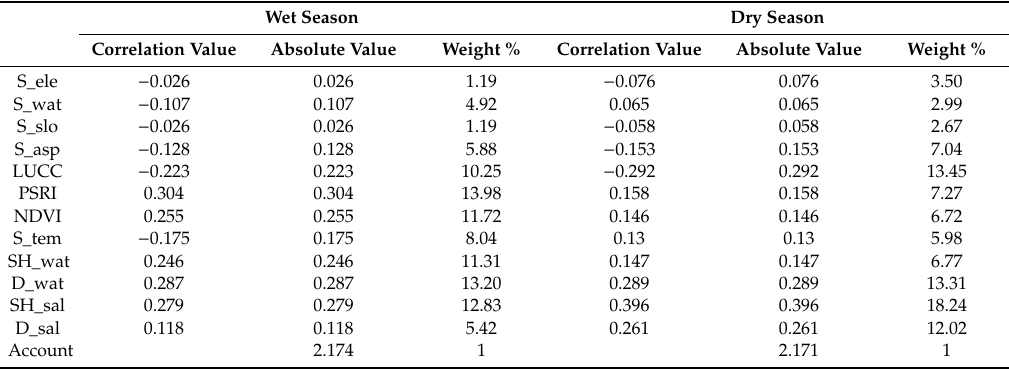
Table 4. Weight of soil salinization risk assessment factors in dry and wet